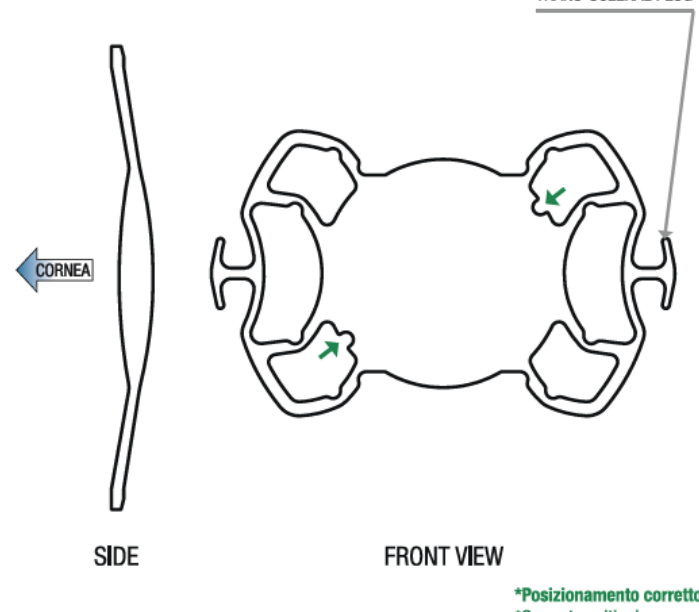
Figure 1. SOLEKO FIL SSF Carlevale lens.